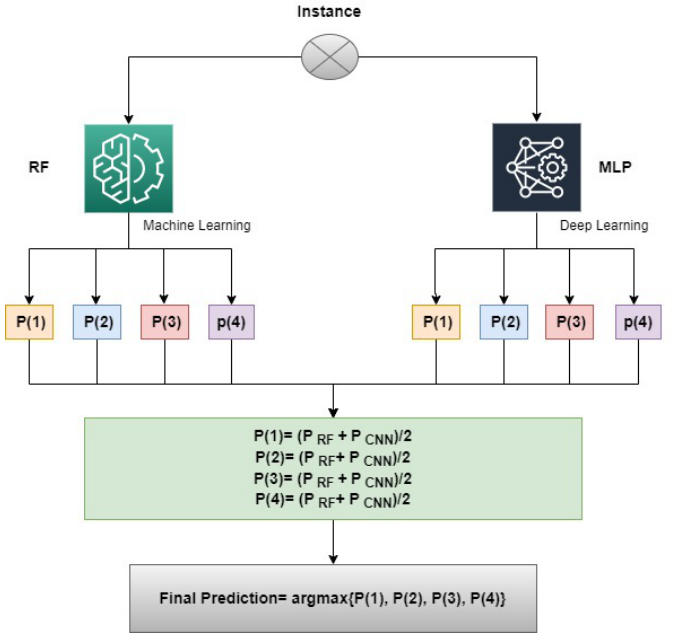
Figure 2. Architecture of the proposed RFMLP model for DDoS attack